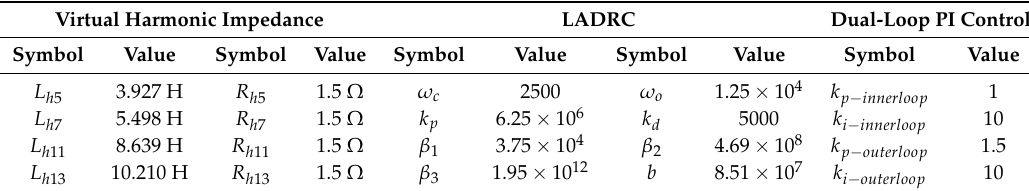
Table 2. Controller Parameters in Simulations.